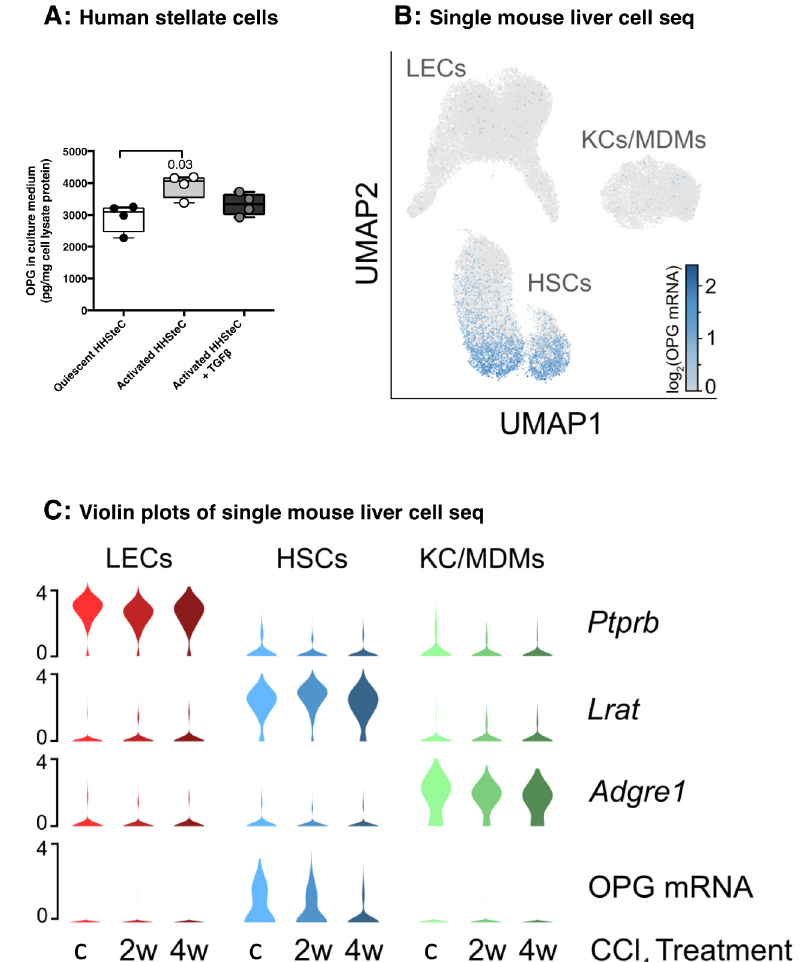
Figure 3. Human and murine hepatic stellate cells produce OPG. ( A ) Activated human hepatic stellate cells (HHSteC) produced significantly more OPG than quiescent HHSteC, but not when they were also treated with TGF β 1. HHSteC were activated by culturing on uncoated plastic. Groups were compared using a Friedman test with a Dunn’s correction for multiple testing, and p < 0.05 was considered significant. (B) Uniform Manifold Approximation and Projection (UMAP) showing murine hepatic stellate cells (HSCs), liver endothelial cells (LECs), and Kupffer cells (KCs)/Monocyte-